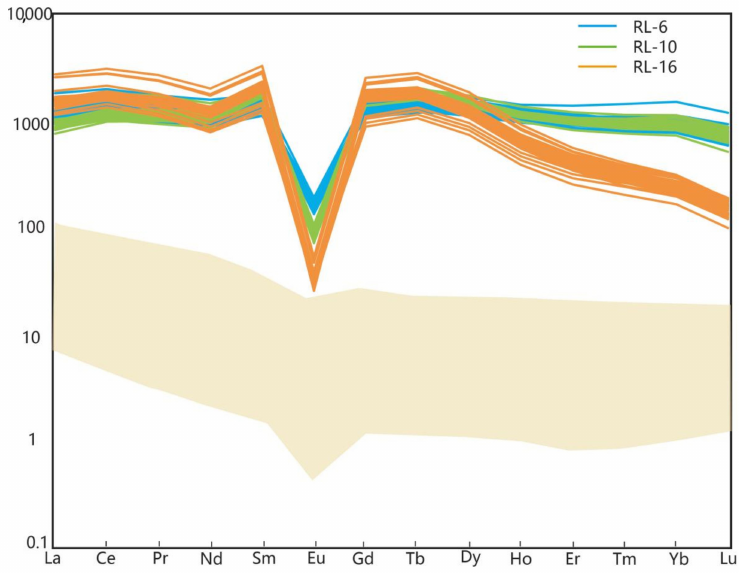
Figure 7. Chondrite-normalized REE patterns of apatite from the RL-6, RL-10, and RL-16 samples [36]. Pale yellow area is the REE pattern of host